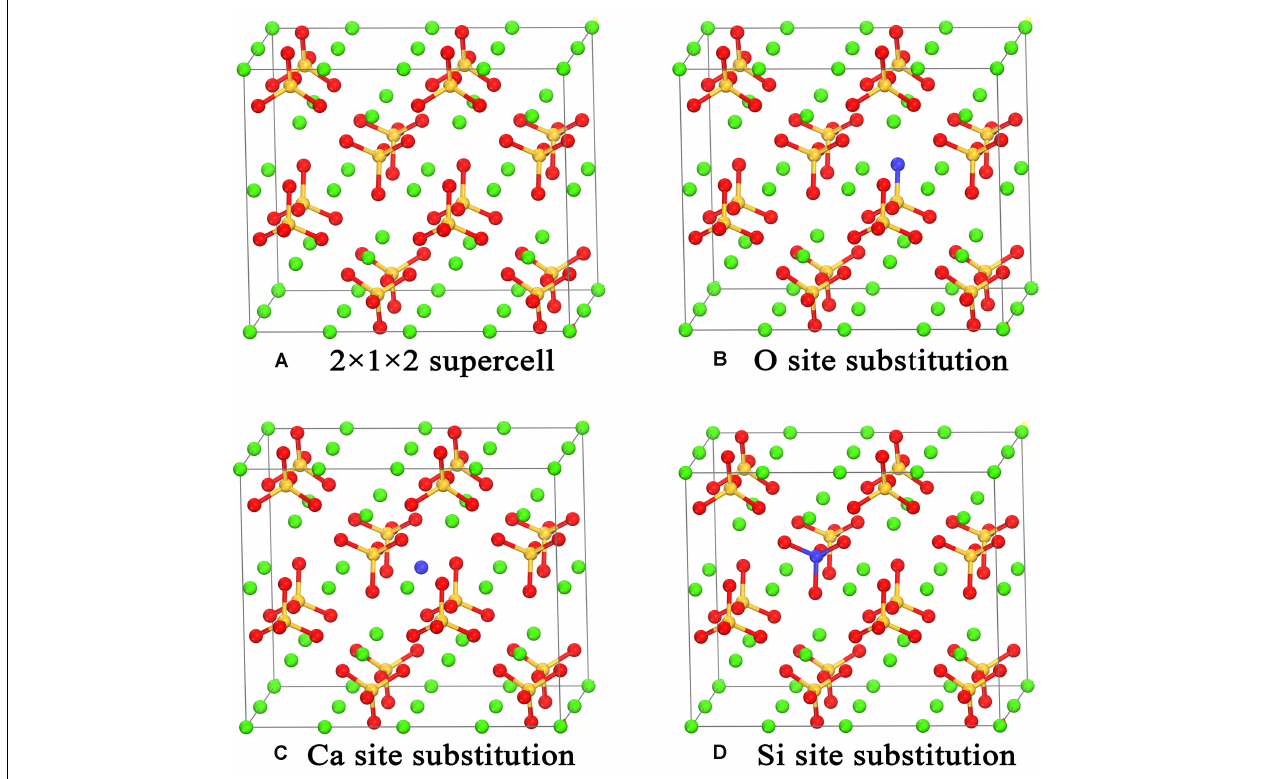
FIGURE 1 | Crystal models of the pristine (A) , O site substituted (B) , Ca site substituted (C) , and Si site substituted (D) γ -Ca 2 SiO 4 . The green, orange, and red spheres are Ca, Si, and O atoms, respectively. The blue spheres indicate the atom sites for different types of substitution.